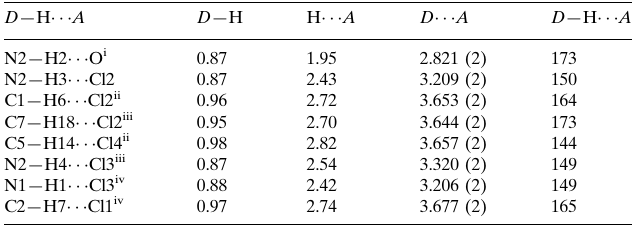
Hydrogen-bond geometry (A˚ , (cid:2)